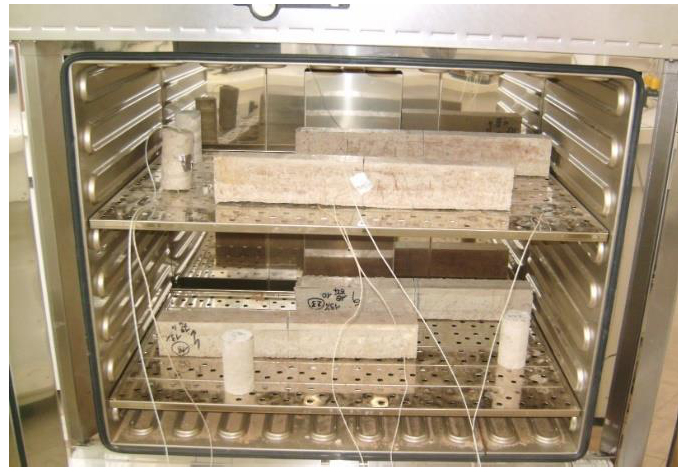
Figure 4. Temperatures control through installation of thermocouples.